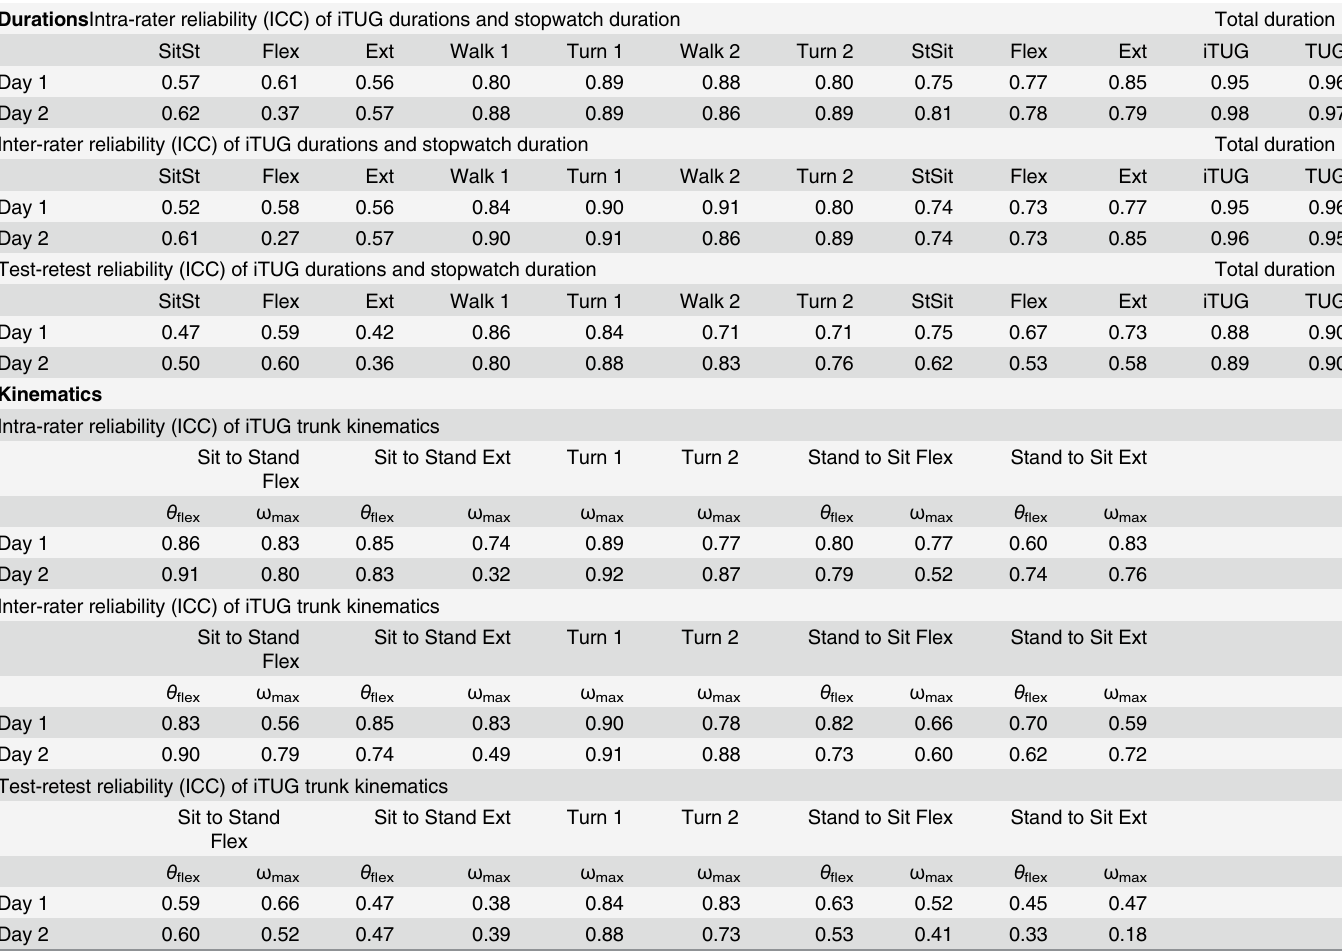
Table 4. Intra-rater, inter-rater and test-retest reliability of the TUG durations (s) and the trunk kinematics expressed in angular displacement of the flexion ( θ flex ) and the extension ( θ ext ) phase and the maximum angular velocity ( ω max ) of the TUG (n =